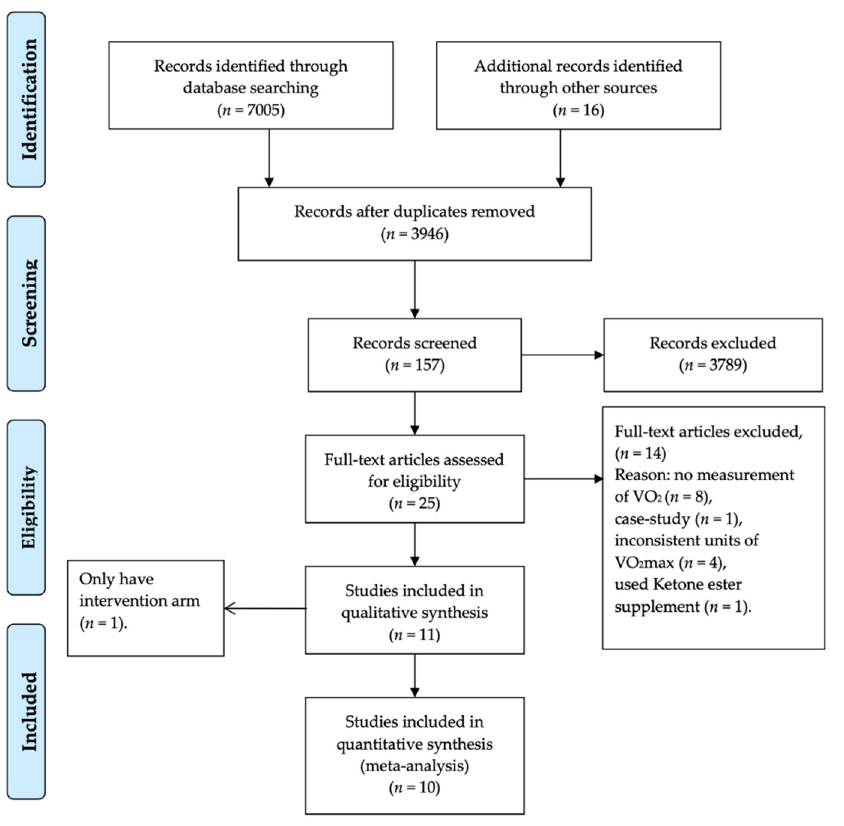
Figure 2. Flowchart for studies in the meta-analysis.